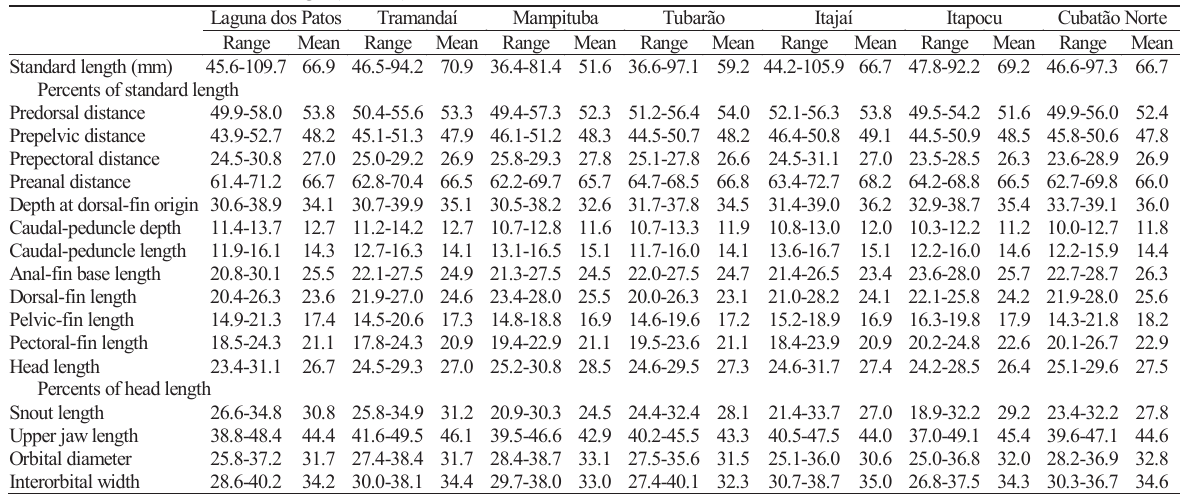
Fig. 8. Astyanax laticeps , UFRGS 4576, male, 49.2 mm SL. SEM image of upper and lower jaws, right side. Scale bar = 1 mm. Table 2. Morphometric data of populations of Astyanax laticeps . Laguna dos Patos system (n = 68), rio Tramandaí drainage (n = 77), rio Mampituba drainage (n = 26), rio Tubarão drainage (n = 16), rio Itajaí drainage (n = 25), rio Itapocu drainage (n = 15), and rio Cubatão Norte drainage (n =